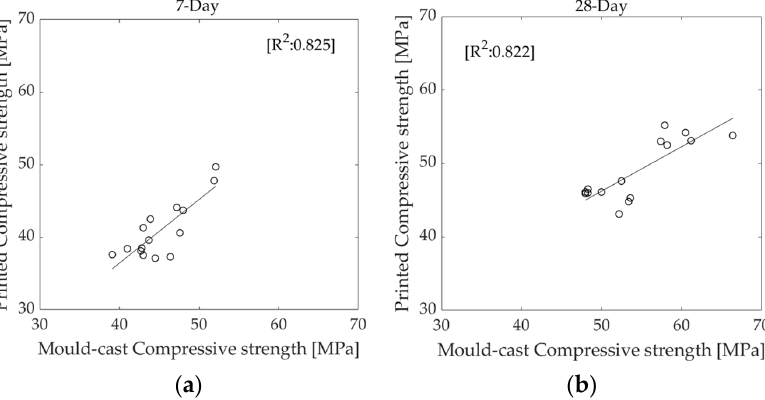
Figure 6. Showing correlation between mould ‐ cast and printed members for ( a ) compressive strength at 7 days and ( b ) compressive strength at 28 days.